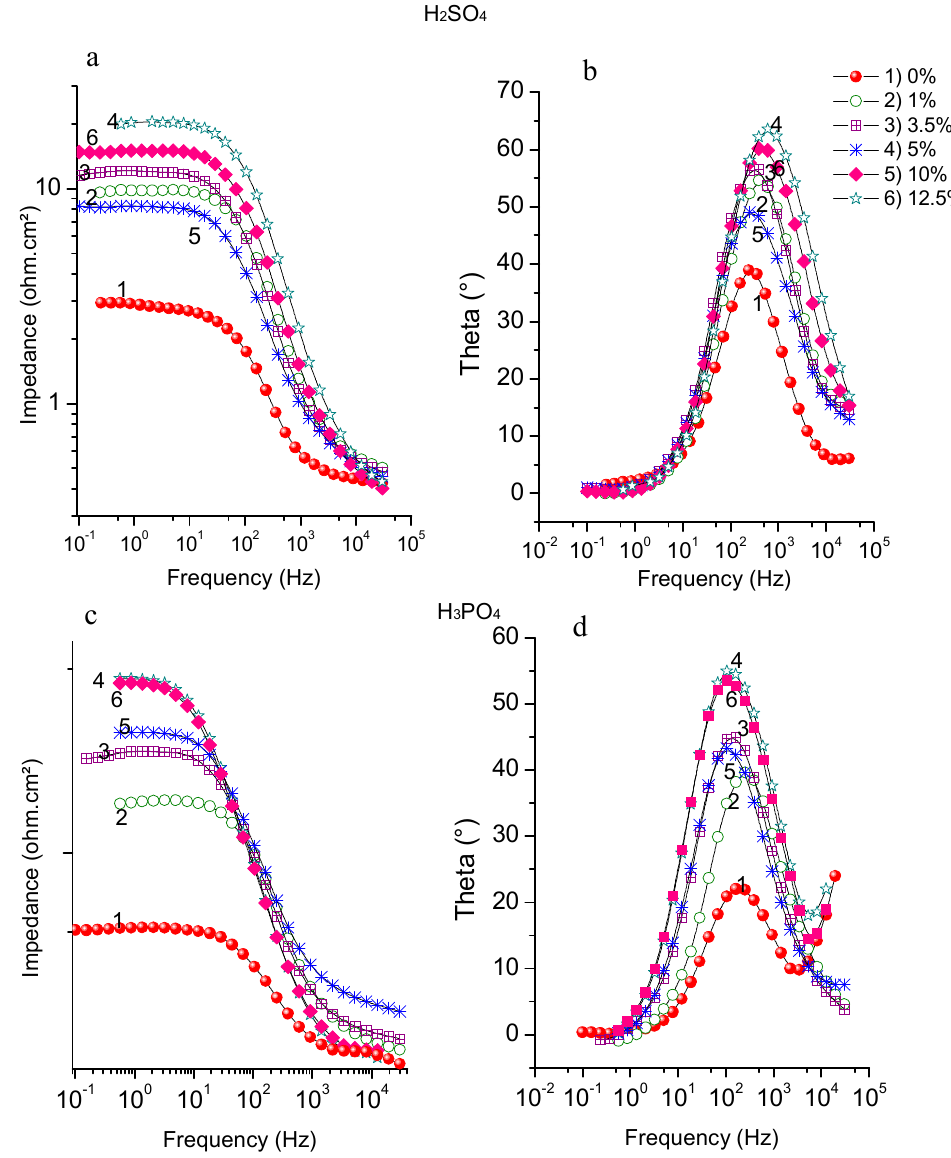
Figure 2. Bode plots ( a ) and ( b ) in H 2 SO 4 , ( c ) and ( d ) in H 3 PO 4 for Carbon steel in the presence in absence and presence of different concentrations of ASMS at 298 °K.